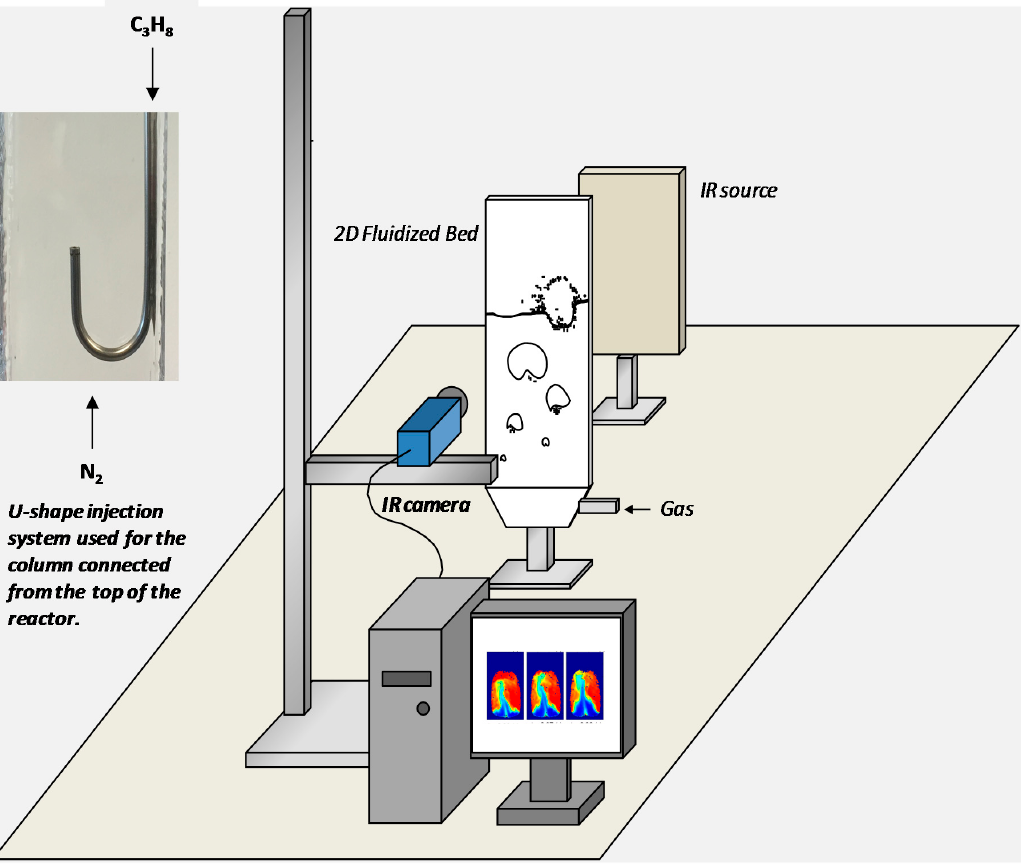
Figure 3. Schematic representation of the experimental setup used in this work for the calibration of all variables in the technique and a detailed image of the injection system.